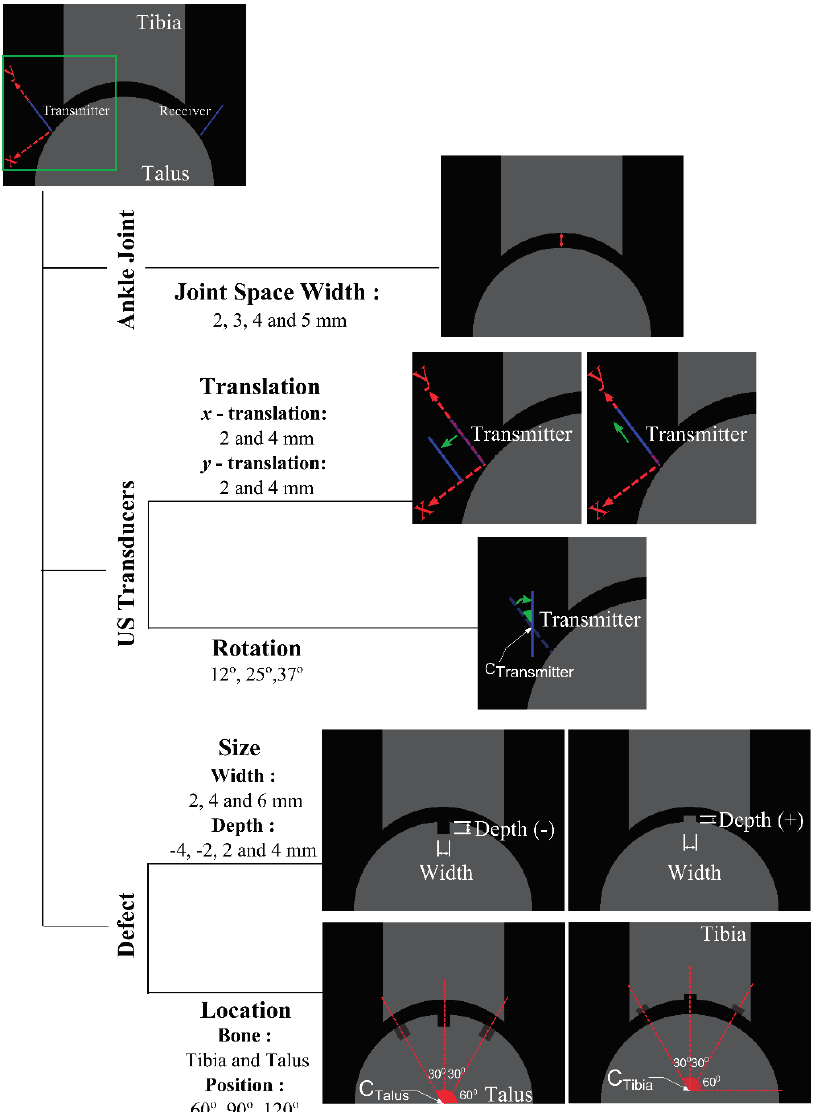
Figure 2. Representation of parameters related to the ankle joint ( i.e. , joint space width), US transducers ( i.e. , translation and rotation of US transducer acting as transmitter) and defect ( i.e. , width, depth and location). Joint space width values are varied from 2 mm to 5 mm ( i.e. , reference simulation model) in intervals of 1 mm. Translations of US transducer were ranged from 2 mm to 4 mm. The US transducer rotated 37° around its center implies that it is perpendicularly aligned to the talar surface, whereas the other two angles were arbitrarily chosen: 12°, and